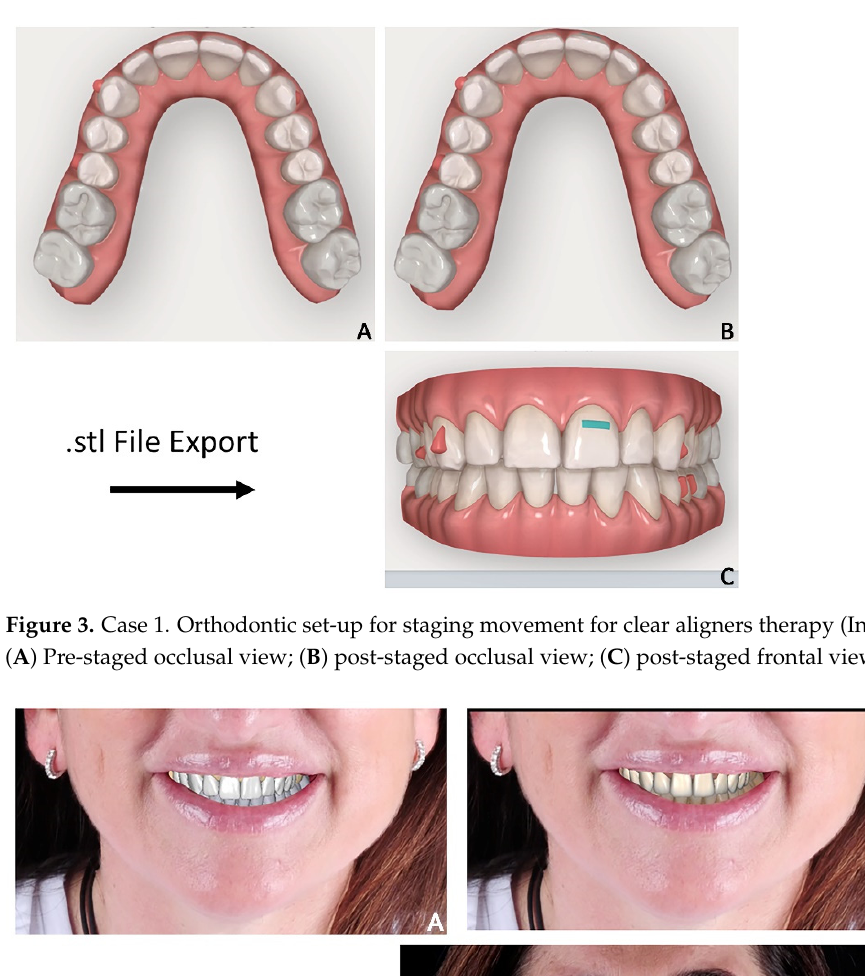
Figure 4. Case 1. Digital wax-up superimposed onto 2D facial photograph. ( A , B ) Color selection of veneers within low-third extra-oral view; ( C ) closer smile view; ( D ) facial extra-oral view.